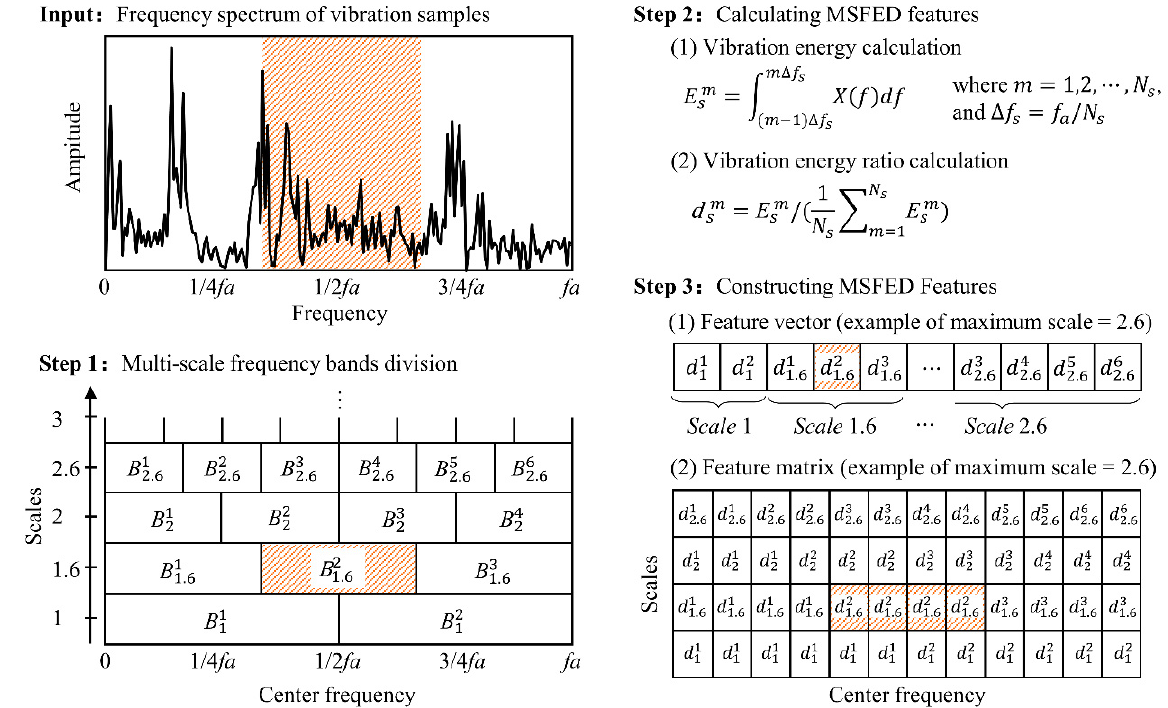
Figure 1. Scheme of the construction of the MSFED feature.